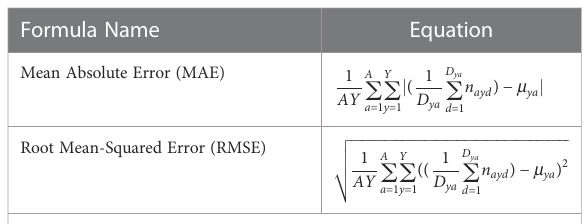
TABLE 2 Formulas used to compare the fi ts of a single replicate glider sample in stratum a , year y and dive d to the population means ( m ya ).